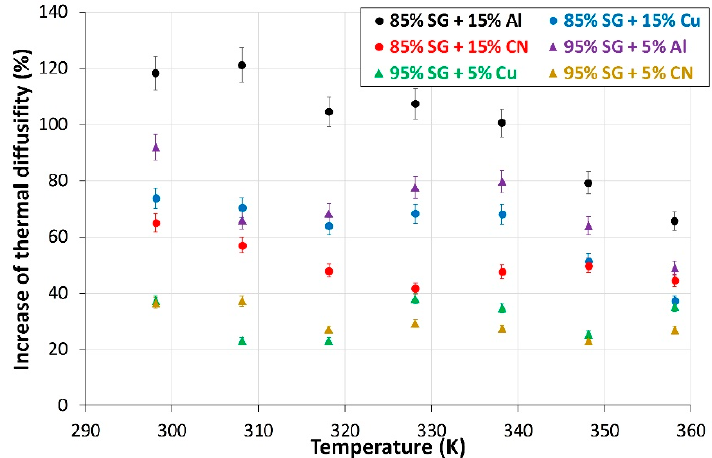
Figure 7. The e ff ect of Al, Cu, and CNT additives to silica gel on the thermal di ff usivity of the SG-based Figure 7. The effect of Al, Cu, and CNT additives to silica gel on the thermal diffusivity of the SG- adsorption based adsorption bed.